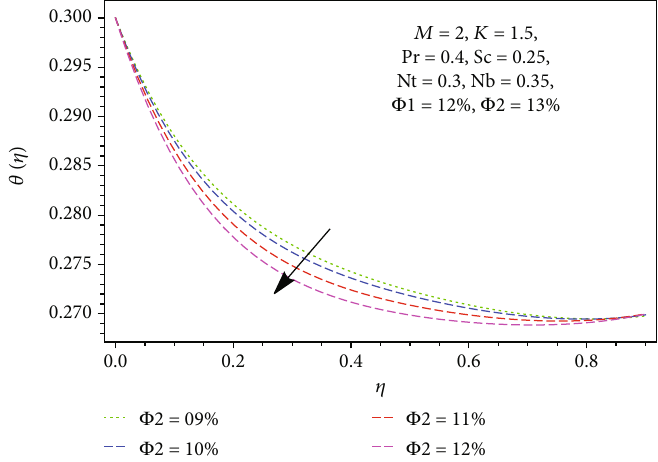
Figure 19: In fl uence of nanoparticle fraction ϕ